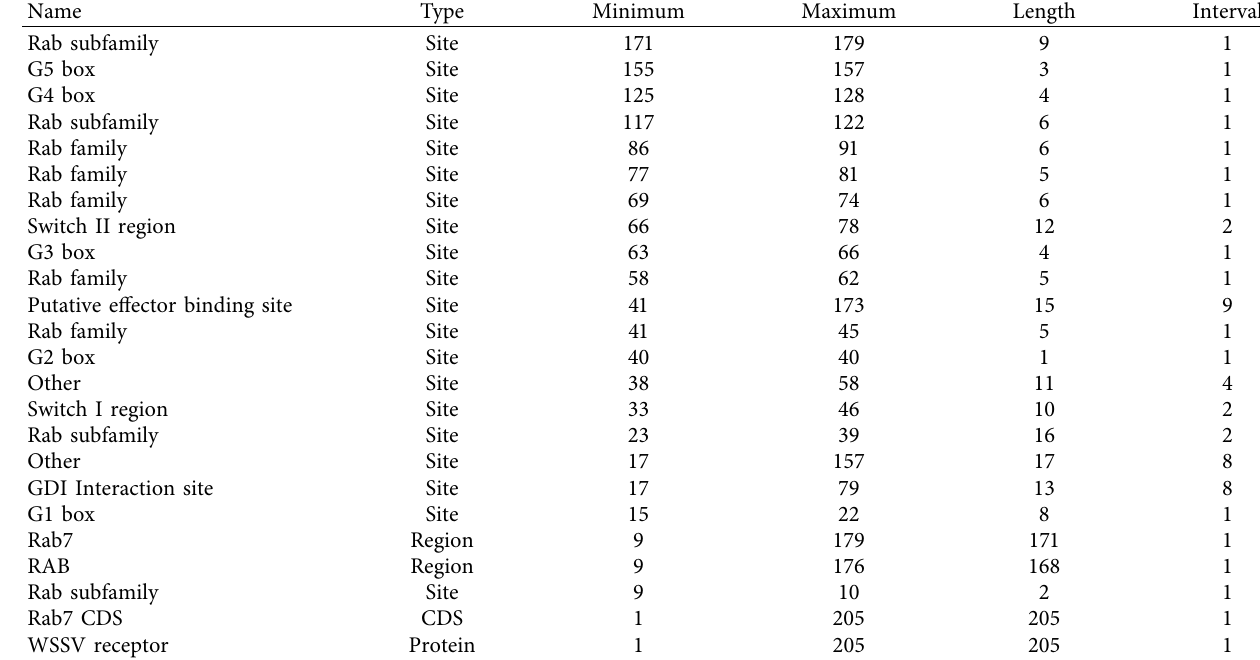
Table 1: Annotation results of Rab7 protein sequences using geneious prime version 2020.1.